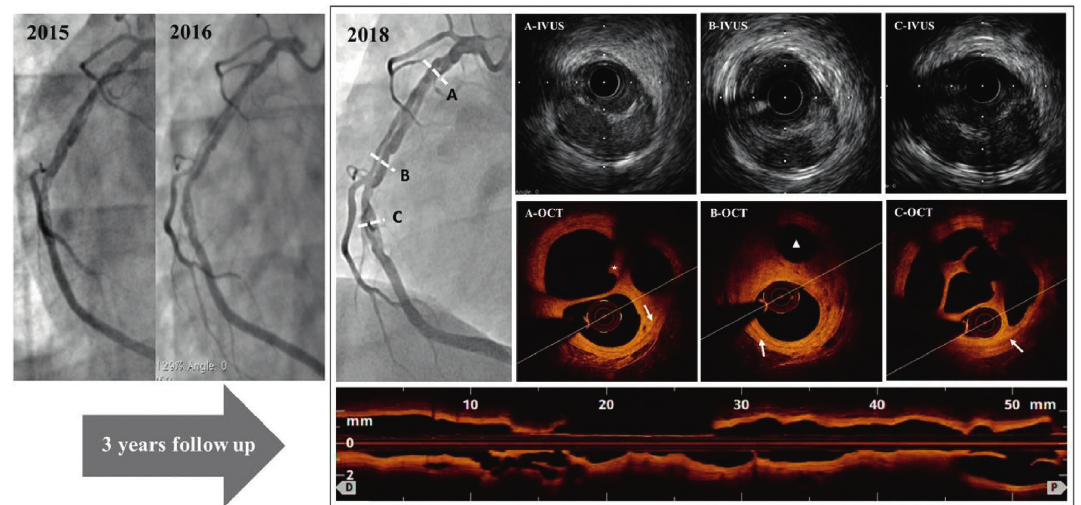
Figure 2: The progress of the braid-like RCA in patient #1 and intracoronary details. Patient #1 experienced acute anterior STEMI in 2015 and a braid-like RCA was discovered incidentally during primary PCI of the LAD. Follow-up CAG in 2016 and 2018 showed little change except for the channel walls becoming smoother and clearer. The cross section intracoronary images drawn from the proximal (A), middle (B), and distal parts (C) are displayed. Intravenous ultrasound (IVUS) detected small channels within the vessel with limited resolution. OCT clearly discerned the signal-rich, high backscattered septa between the microchannels with smooth inner borders and the traces of intraluminal thrombi (star). The three-layer wall structure of the inherent RCA surrounding all of the channels could be defined (arrow). The acute marginal branch originated from a separate channel (triangle). Table 4: Information of interventional procedure and follow-up Follow-up at